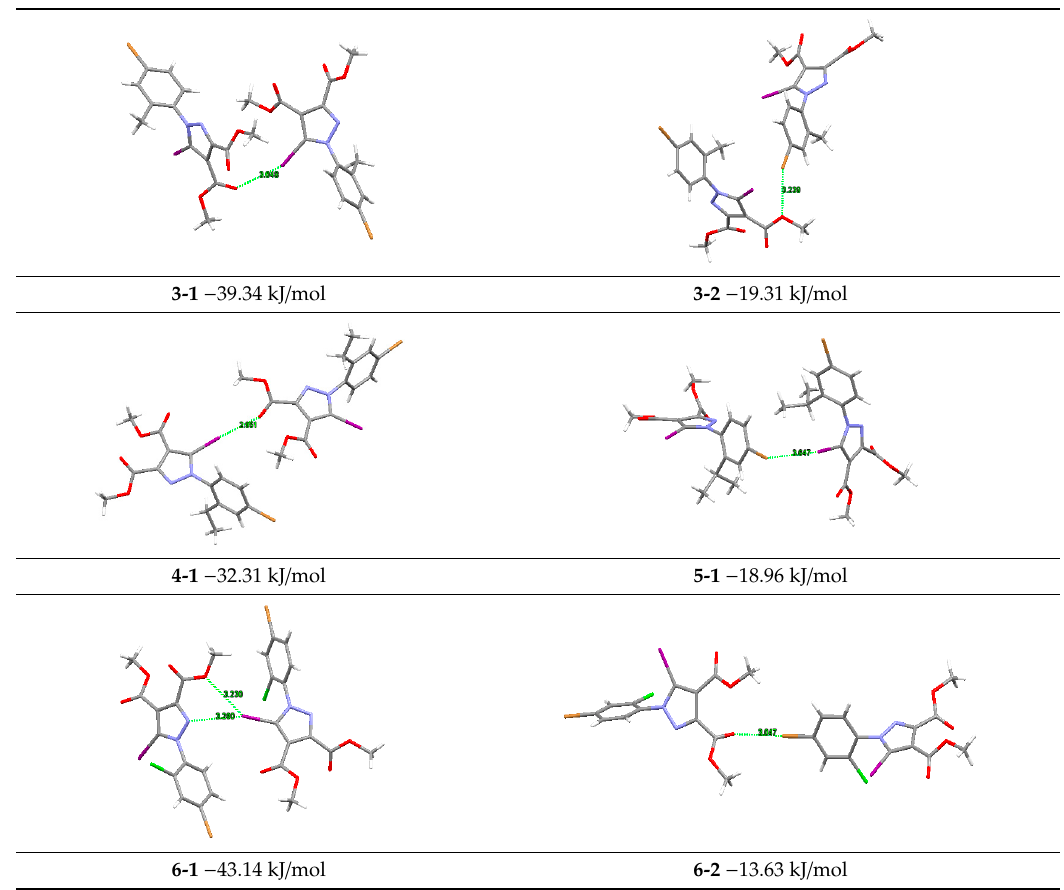
Table 4. Cont. Crystals 2020 , 10 , x FOR PEER